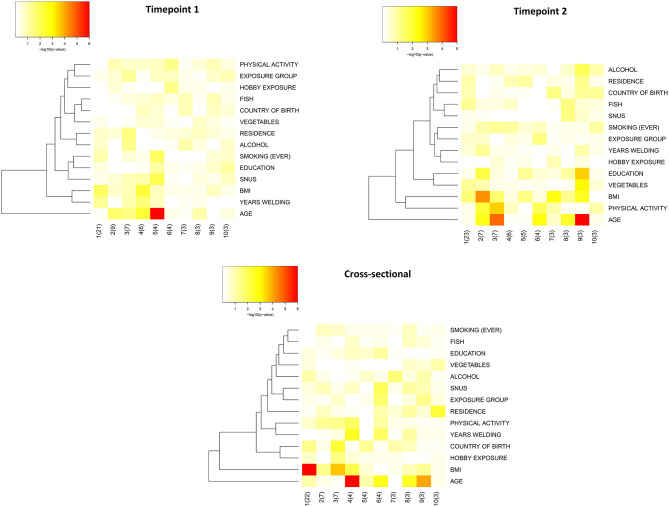
Heatmaps of the principal components (PC) that explain the variation in the study groups. Heatmaps were constructed using input data from linear regression of association between the principal components of the data and the biological annotations. The influence of the biological annotations on the overall variation is plotted in a heatmap based on the p-value of the association. Input data was the normalized protein expression values (on a log2-scale). “group” refers to occupational group i.e., welders and controls; “residence” refers to current residence in large and small cities as compared with towns and countryside; “hobby exposure” exposure to welding fumes, dust, engine exhaust or engine diesel during leisure activities; “country of birth” is categorized as Sweden or outside Sweden; “education” is assigned to 5 categories for education from secondary school to university studies; “vegetables” frequency of intake of vegetables and is assigned to 8 categories from 3 per day or more to never; “fish” frequency is based on 7 categories from once per day or more to never; “physical activity” is based on 4 categories from sedentary to intensive physical activity; “ever smoking” stands for current or previous smoking and is categorized as “yes” and “no”; “alcohol” stands for frequency of alcohol intake and is stratified in 6 categories from every day to never.